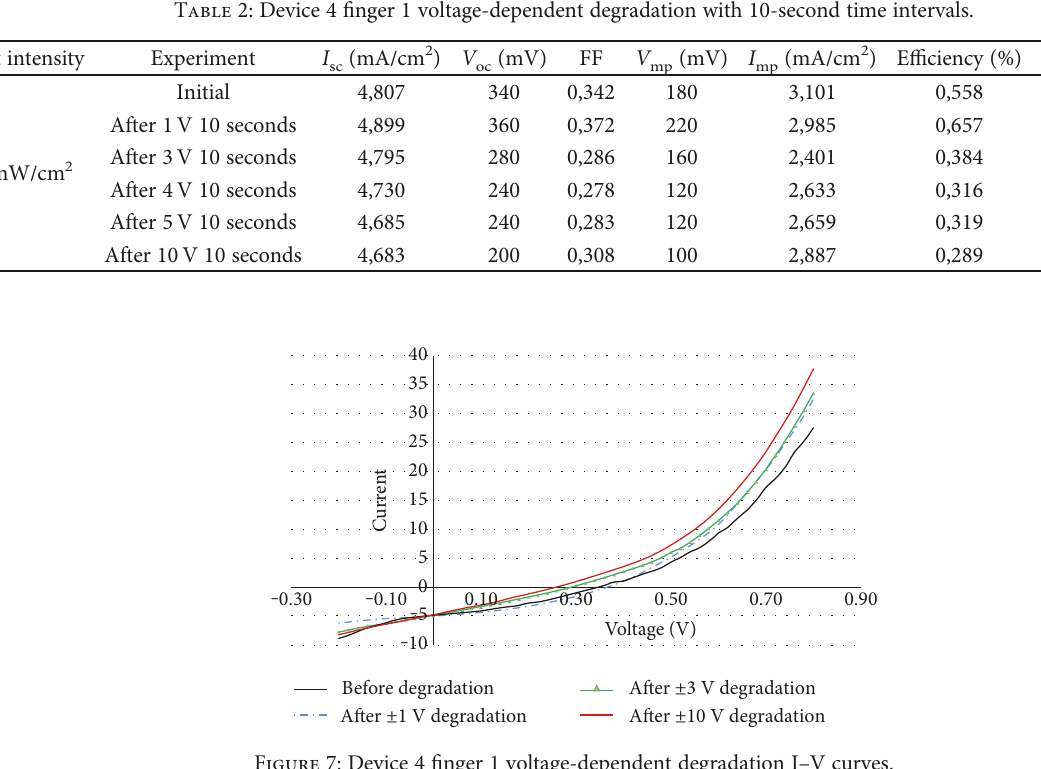
Figure 7: Device 4 fi nger 1 voltage-dependent degradation I – V